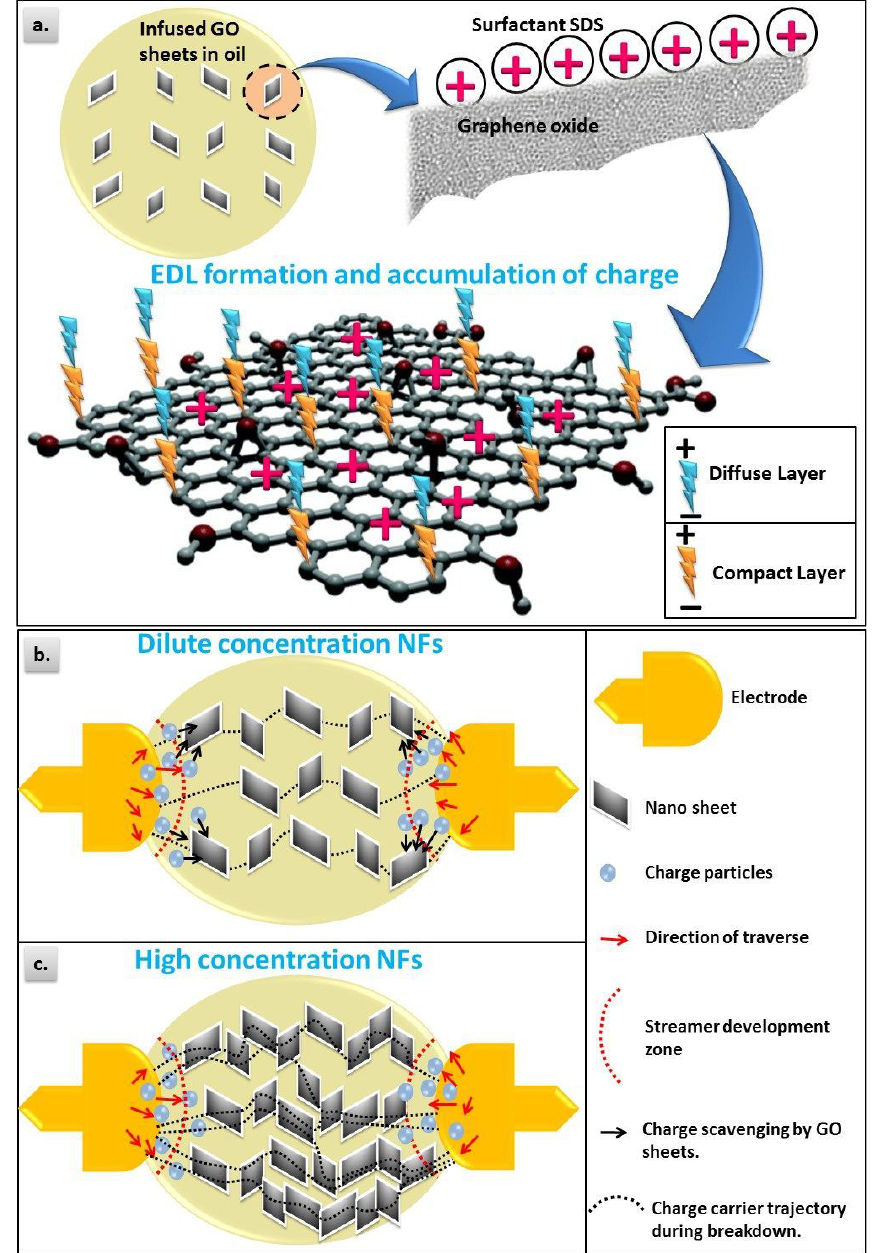
Figure 6. Physical mechanisms behind breakdown strength of nanofluids. ( a ) Electrical double layer (EDL) formation; ( b ) capturing and trapping electrons at low GO weight percentages; ( c ) overlap between adjacent EDLs at high GO weight percentages.